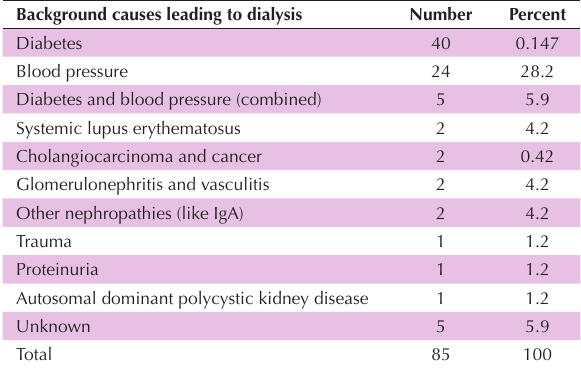
Table 1. Frequency distribution and percentage of background causes leading to dialysis in hemodialysis patients Background causes leading to dialysis